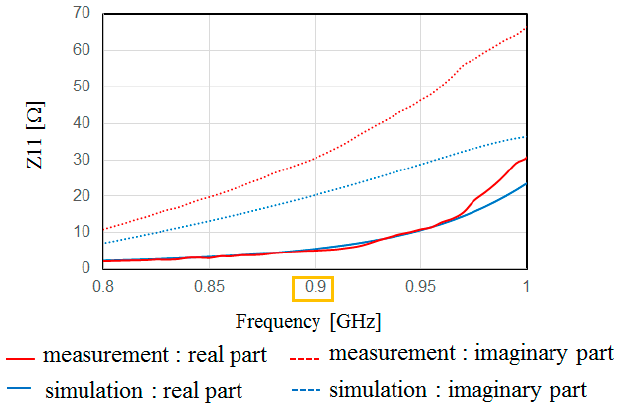
Figure 15. Measured and simulated frequency characteristics of Z 11 calculated from s -parameters.